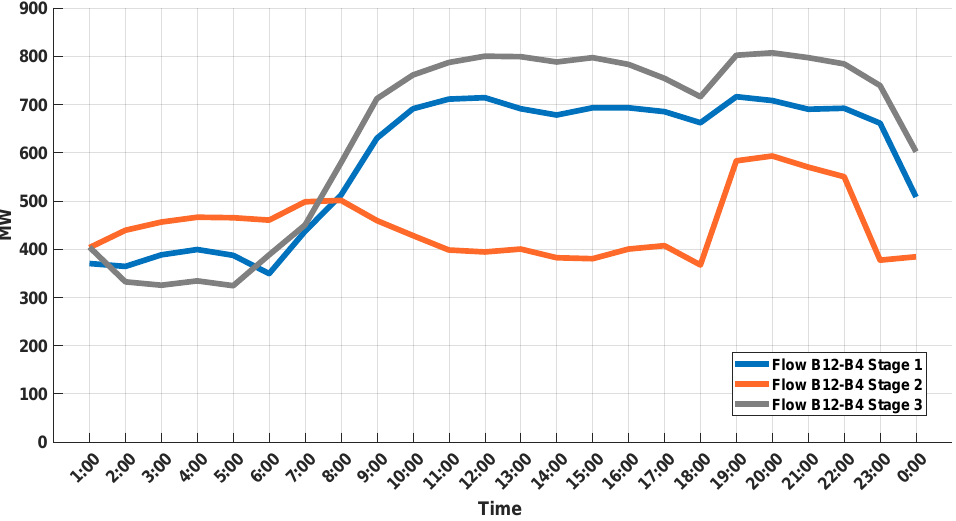
Figure 31. Power flow variation from bus 12 to bus 4 (MW).